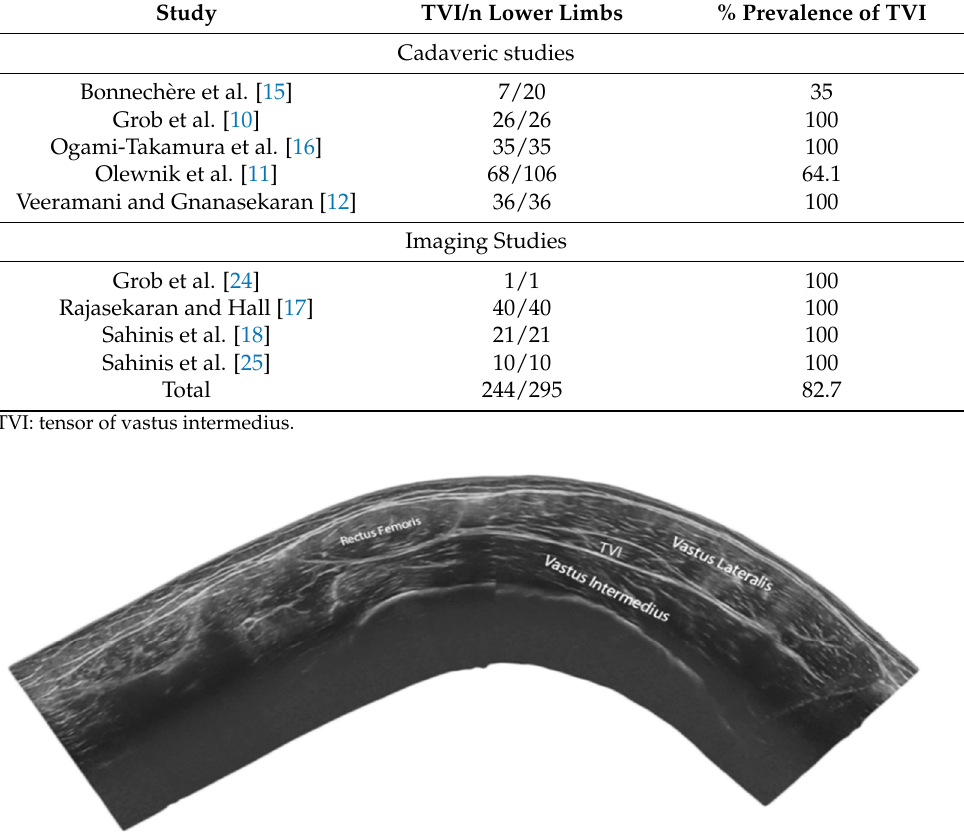
Figure 3. Representative extended field of the view ultrasound image of rectus femoris (RF), the vastus lateralis (VL), the vastus intermedius (VI) and the tensor of the vastus intermedius (TVI) obtained from the anterior region of the thigh obtained in our laboratory.